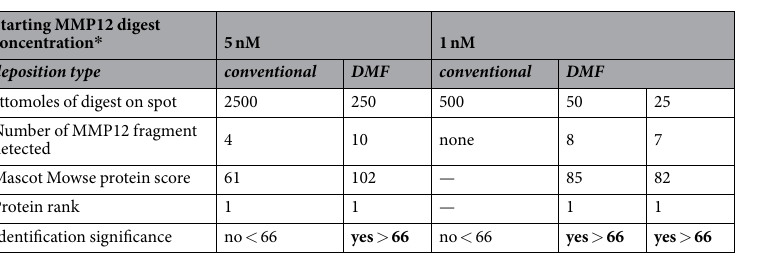
Table 1. Table summarizing quantities and results obtained for MMP12 identification with conventional or DMF deposition. * Before matrix